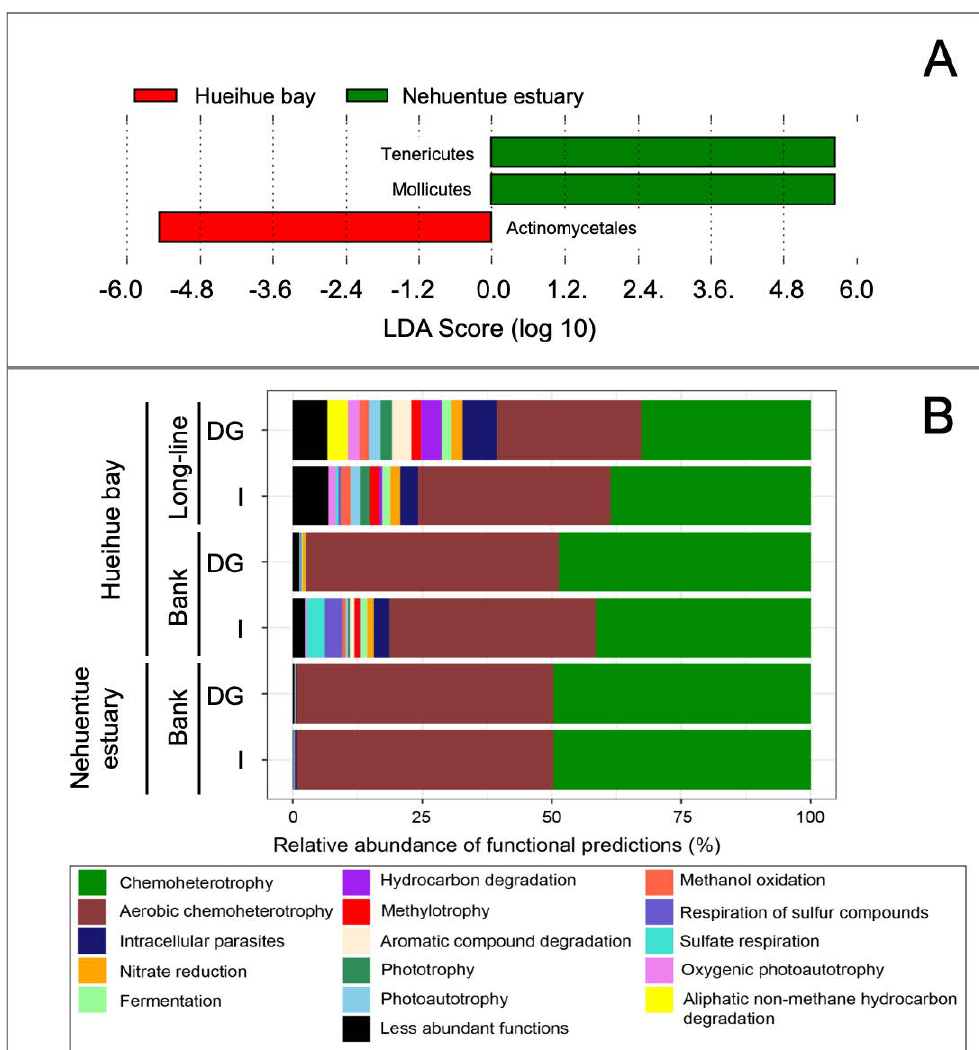
Figure 5. ( A ) Key phylotypes of the bacterial community in tissue samples of Choromytilus chorus specimens grown in Nehuentue Estuary and Hueihue Bay as revealed by Linear discriminant analysis Effect Size (LEfSe). ( B ) Mean relative abundances of microbial functional groups of the bacterial community in tissue samples of Choromytilus chorus specimens grown in Nehuentue Estuary and Hueihue Bay as revealed by FAPROTAX